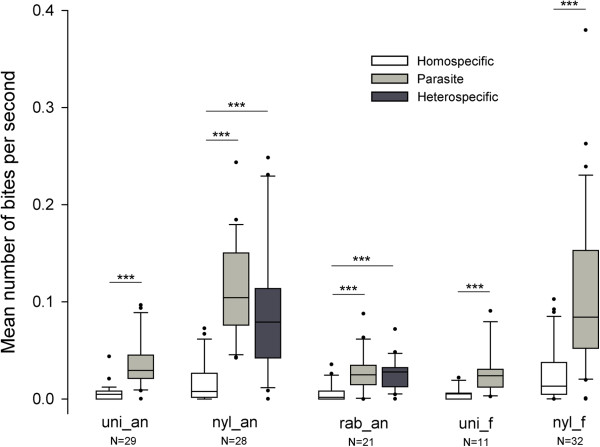
Box-and-whisker plots for bite rates inflicted in recipient colonies. Introductions were carried out in colonies from populations of M. ravouxi, T. unifasciatus, T. nylanderi and T. rabaudi from Anduze (myr_an, uni_an, nyl_an and rab_an respectively), and of T. unifasciatus and T. nylanderi from Fontainebleau (uni_f and nyl_f respectively). Box plots show the median and 25-75% percentiles. Whiskers show all data excluding outliers outside the 10th and 90th percentiles (circles). Figures under bars indicate number of tests. *** P < 0.001.